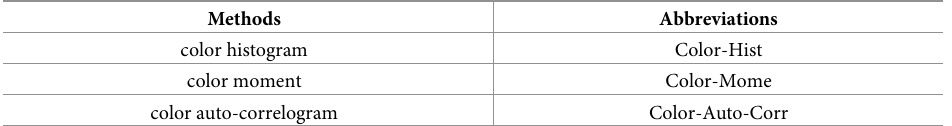
Table 2. Color features and abbreviations.